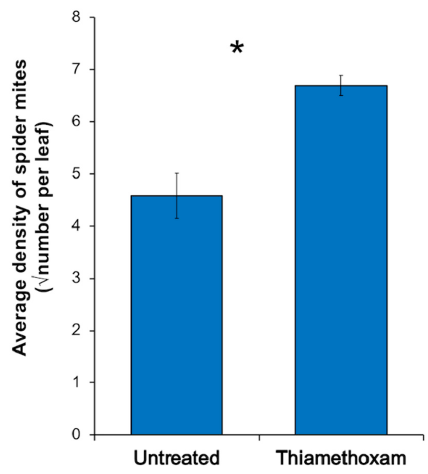
Figure 6. Effect of thiamethoxam seed treatments on density of spider mites on soybean. Values are means ± one standard error. An asterisk designates a significant difference between treatments ( P < 0.05).